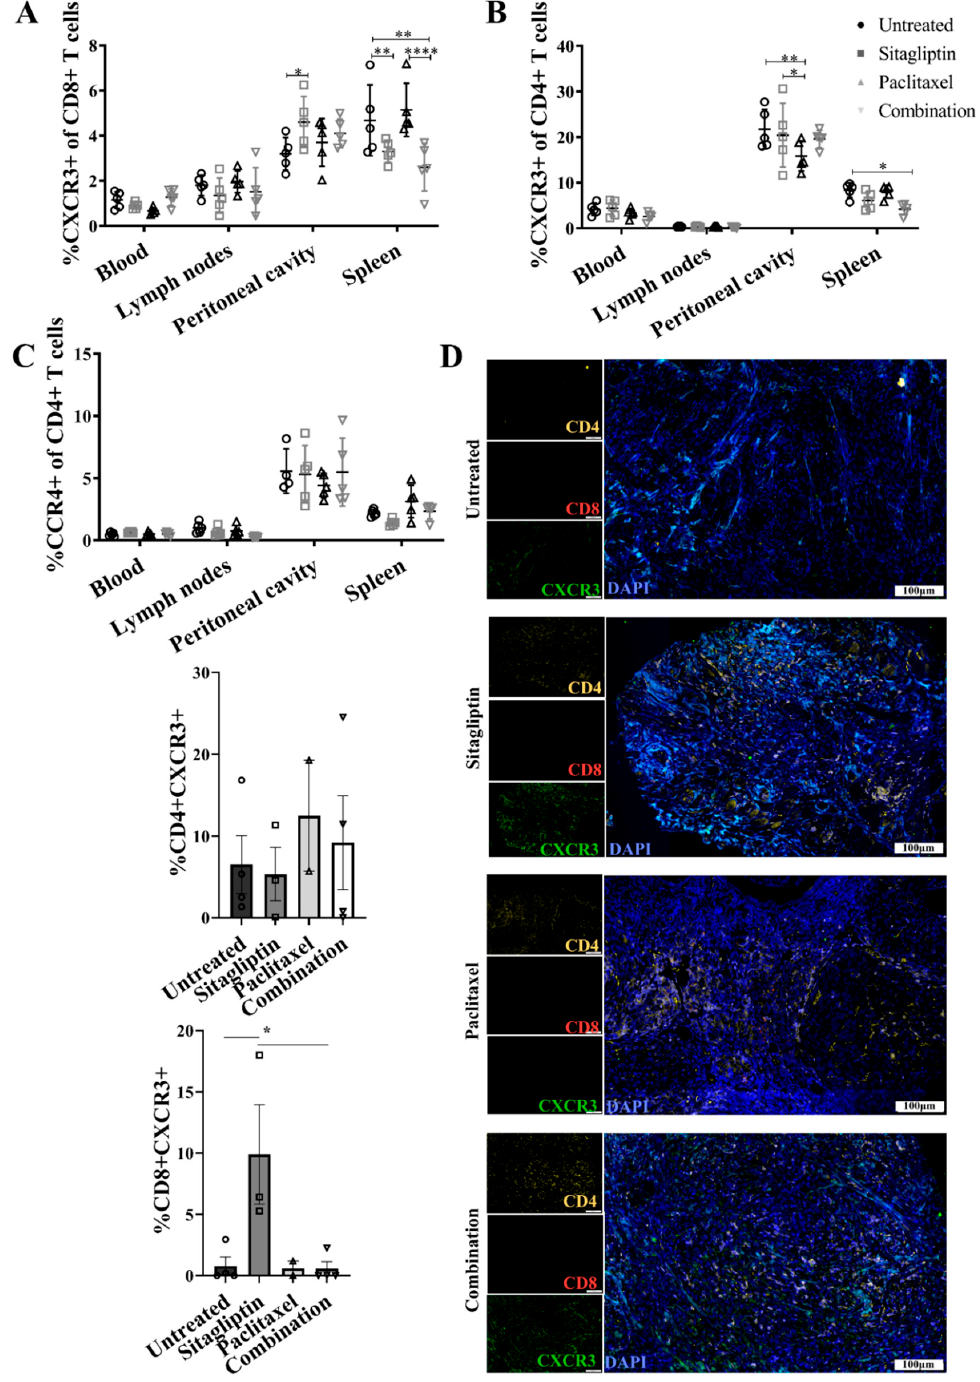
Figure 6. Chemokine receptor expression in ID8 tumour-bearing mice treated with sitagliptin and paclitaxel. Leukocytes were isolated from the blood, lymph nodes, peritoneal cavity and spleen of ID8 pROSA -iRFP720-bearing mice at week four post-inoculation and examined using a BD LSRFortessa X-20 (BD Biosciences). Percentage of ( A ) CXCR3+ CD8+ T cells, ( B ) CXCR3+ CD4+ T cells, and ( C ) CCR4+ CD4+ T cells of the corresponding parent population. ( D ) Representative images of ovarian tumour sections stained with CD4 (yellow), CD8 (red) and CXCR3 (green) at four weeks post tumour inoculation. Nuclei were stained with DAPI (blue). Bar graphs show the percentage area of ovarian tumour sections stained with (i) CD4+CXCR3+ and (ii) CD8+CXCR3. Images were acquired using the VS120 Virtual Slide Microscope (Olympus Corporation, Japan) and processed using the Olyvia software v2.9.1 (Olympus Corporation, Japan). Data were analysed by calculating the percentage area of CD4+CXCR3 or CD8+CXCR3+ colocalisation of total tissue area using a consistent binary threshold in ImageJ v1.0 (National Institute of Health, MD, USA). * = p < 0.05; ** = p < 0.01; **** = p <